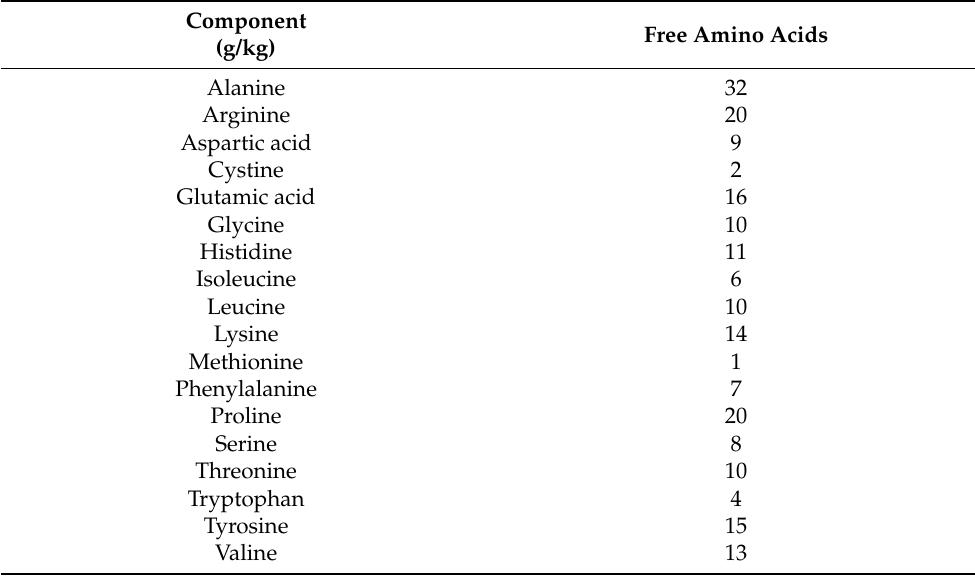
Table 5. Free amino acid profile of insect protein hydrolysate (as declared by